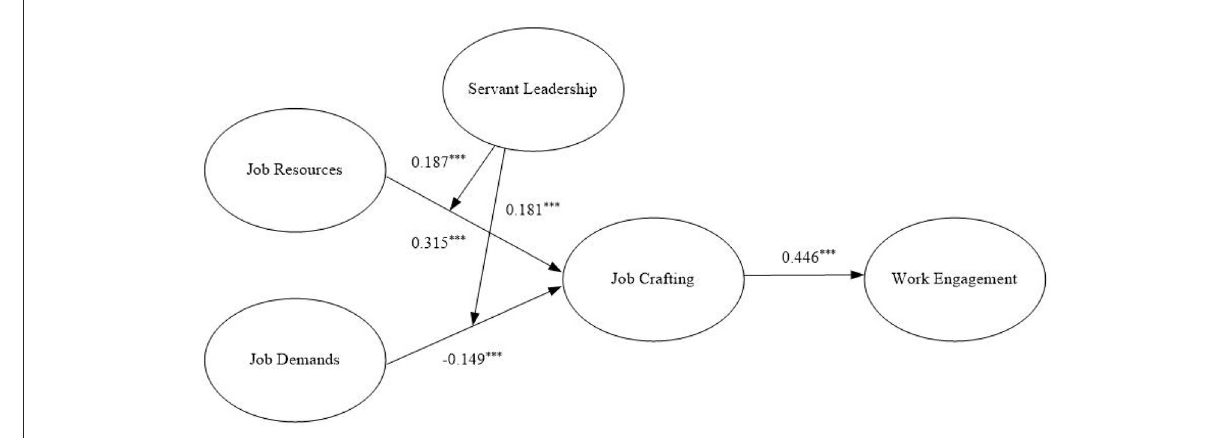
FIGURE2 Results of the theoretical model.